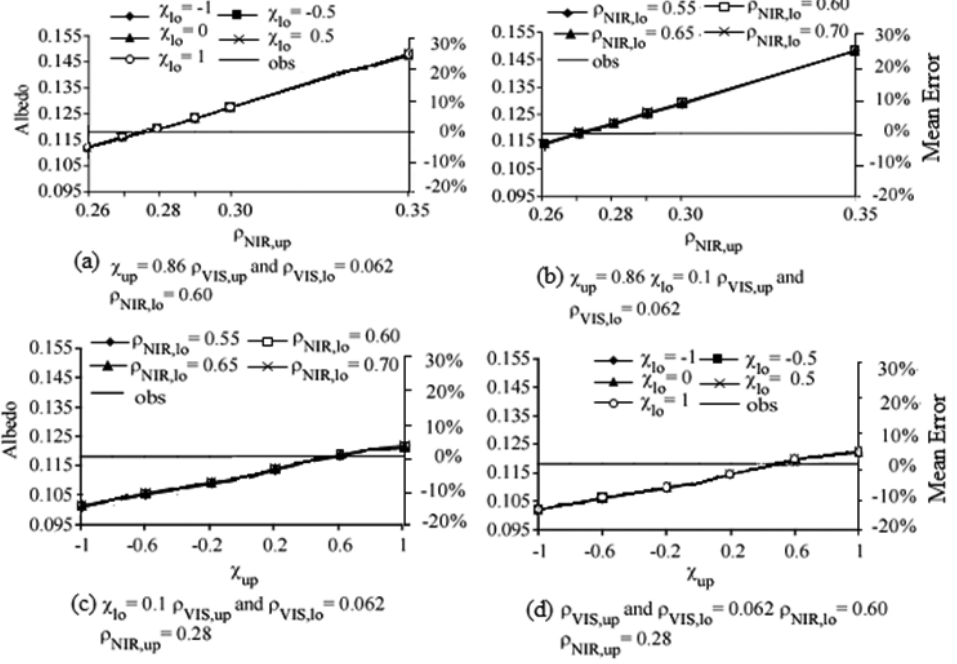
Fig. 2 – Sensitivity analysis of the simulated albedo and its mean error as a function of a) ρ NIR , up and χ lo , b) ρ NIR , up and ρ NIR , lo , c) χ up and ρ NIR , lo , and d) χ up and χ lo , for the Cuieiras Biological Reserve (K34).